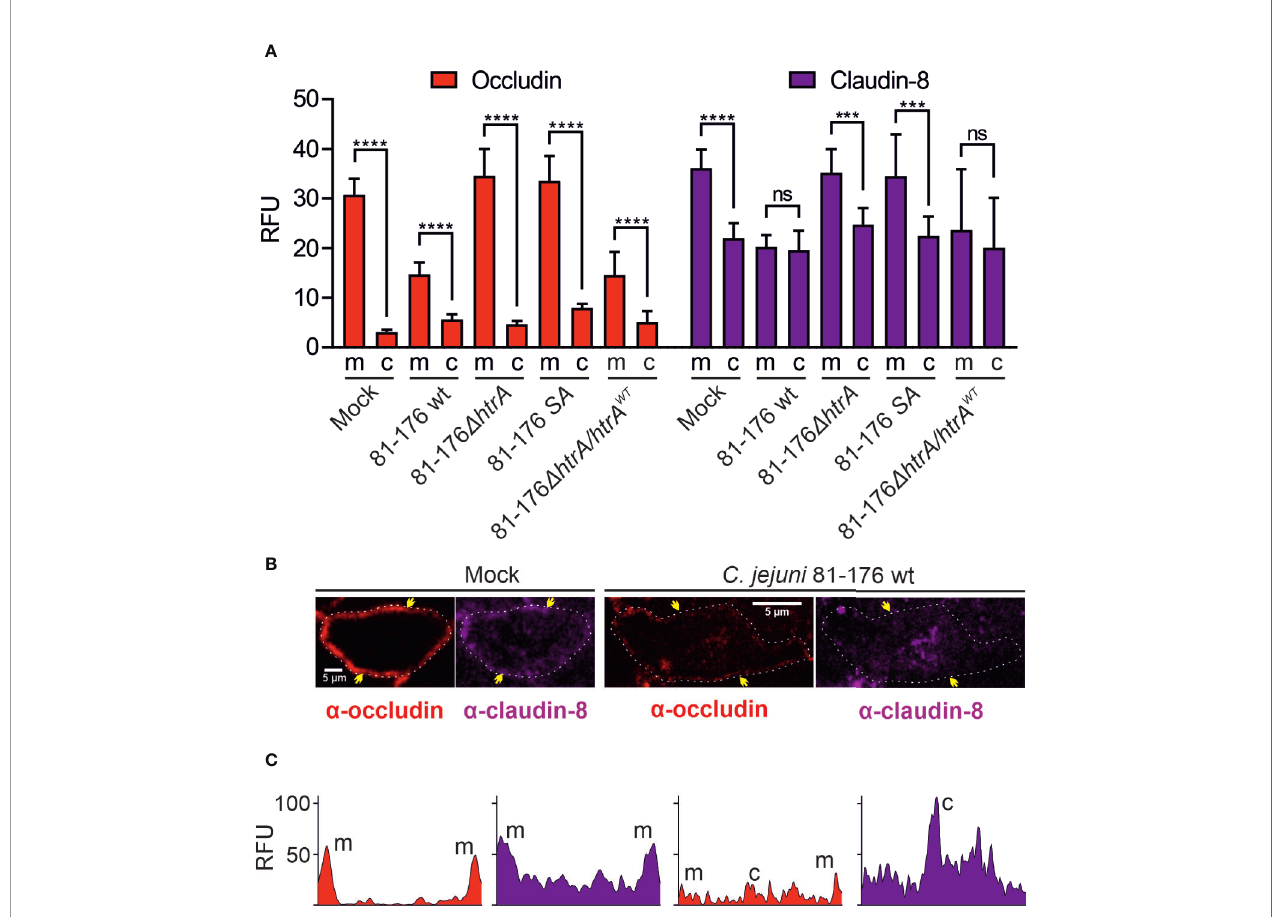
FIGURE 3 | Localization of occludin and claudin-8 proteins in tight junctions and cytoplasm of T84 cells. The mean fl orescence intensity of the proteins was assessed separately in the membrane (m)-associated tight junctions and cytoplasm (c), and was calculated from 10 T84 cells per sample (A) . Single cell analysis of representative T84 cells without or with infection by wt C. jejuni . Infection of T84 cells leads to the drop of fl uorescence intensity of claudin-8 in tight junctions along with its appearance in the cytoplasm (B) . Corresponding fl uorescence intensity plots for occludin and claudin-8 within single cells between two yellow arrows, as marked in panel (B) . When infected with wt C. jejuni , a strong fl uorescence intensity can be found in the cell cytoplasm (C) . RFU, relative fl uorescence units of membrane and cytoplasmic localization. ***p < 0.001, ****p < 0.0001, ns, non-signi fi